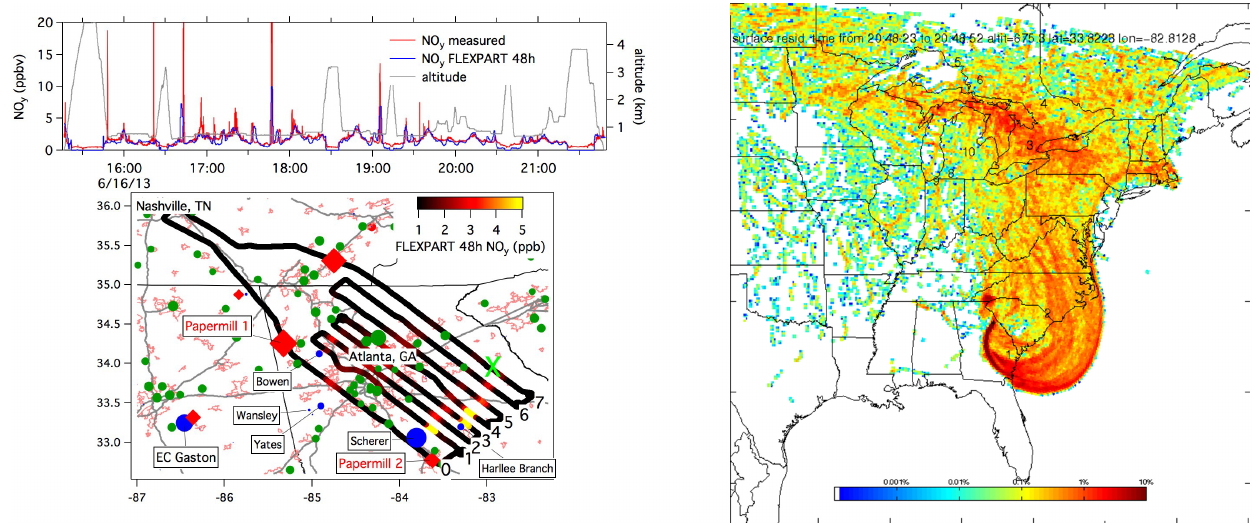
Figure 13. FLEXPART model results: time series of NO y with 48h of accumulation time, the flight track color-coded by modeled NO y and the surface residence time for a point on the last transect downwind of the Harllee Branch power